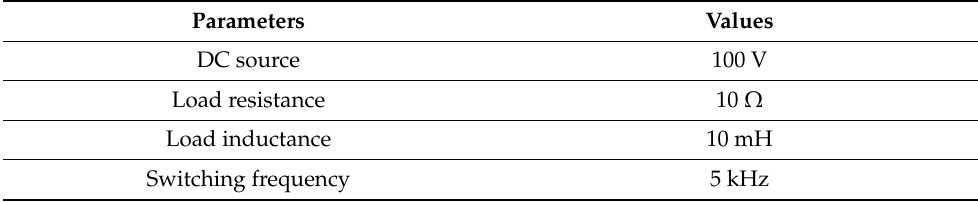
Table 1. Experiment